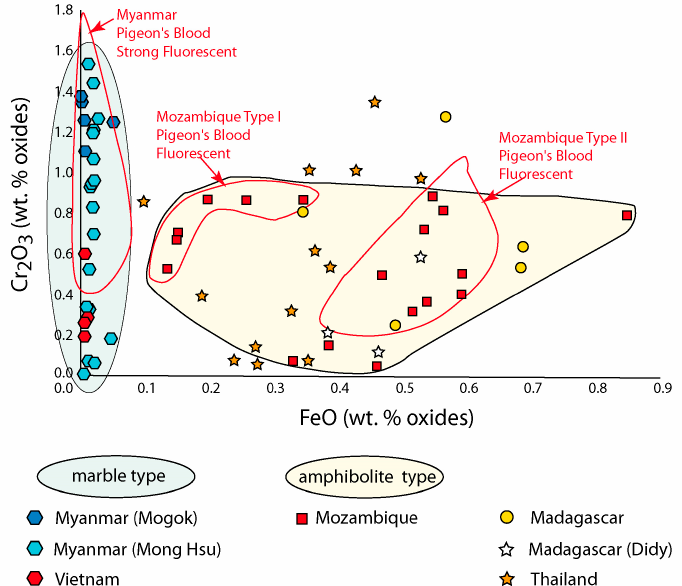
Figure 7. FeO versus Cr 2 O 3 diagram of different pigeon’s blood color of rubies worldwide (modified from [44]. The color of the gem is defined as vivid with high intensity and low tone. The distinction of rubies between Myanmar Pigeon’s Blood Strong Fluorescent (in marble from Myanmar and Vietnam), Mozambique Type I Pigeon’s Blood Fluorescent, and Mozambique II Pigeon’s Blood Fluorescent (both in amphibolite) is correlated with the amount of Fe in the ruby, respectively FeO < 0.1 wt %; 0.1 < FeO < 0.35 wt %; and 0.35 < FeO < 0.6 wt % (data from [44]).